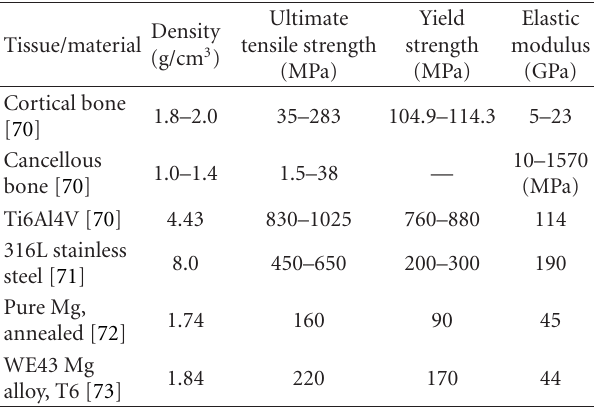
Table 1: Mechanical properties of Mg compared to bone and